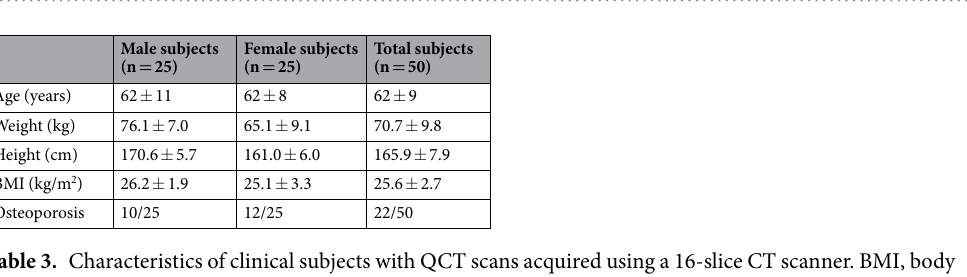
Female subjects (n = 25)